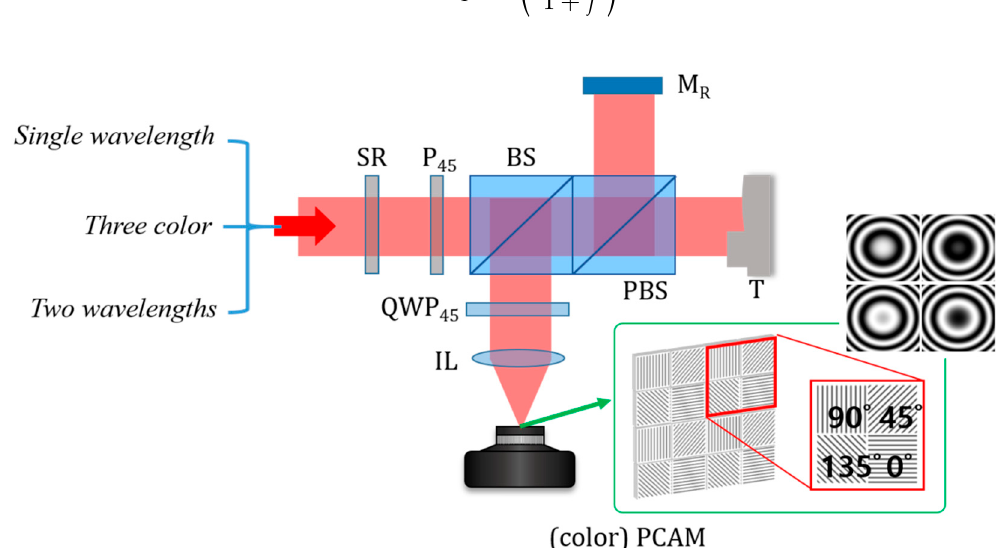
Figure 1. Optical configuration of spatial phase shifting interferometry using a polarization-pixelated camera (PCAM); SR, speckle reducer; P 45 , 45° rotated polarizer; BS, beam splitter; PBS, polarizing beam splitter; QWP 45 , 45° rotated quarter waveplate; IL, imaging lens; M R , reference mirror; T, target; (color) PCAM, (color) polarization-pixelated camera.